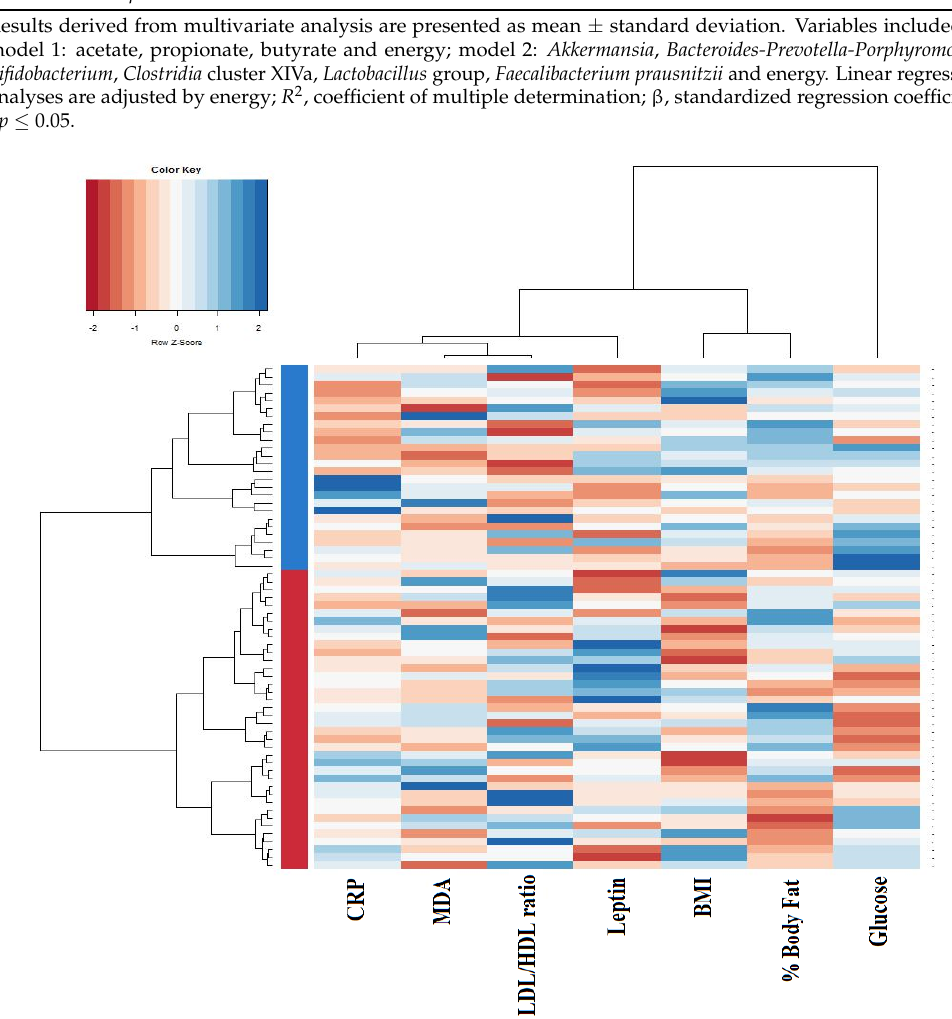
Figure 1. Dendogram clustering based on individual body composition, serum glucose, lipid profile, and oxidative stress biomarkers. The heatmap shows the dendrogram classification for clusters, based on C reactive protein (CRP), malondialdehyde (MDA), LDL/HDL ratio, serum leptin, Body Mass Index (BMI), body fat percentage and serum glucose (columns). Colors in the vertical bar at the left of the heatmap identify Cluster I (red) and Cluster II (blue).